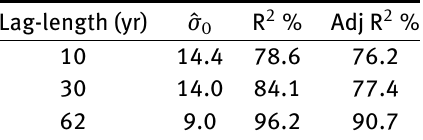
Table 2: Summary